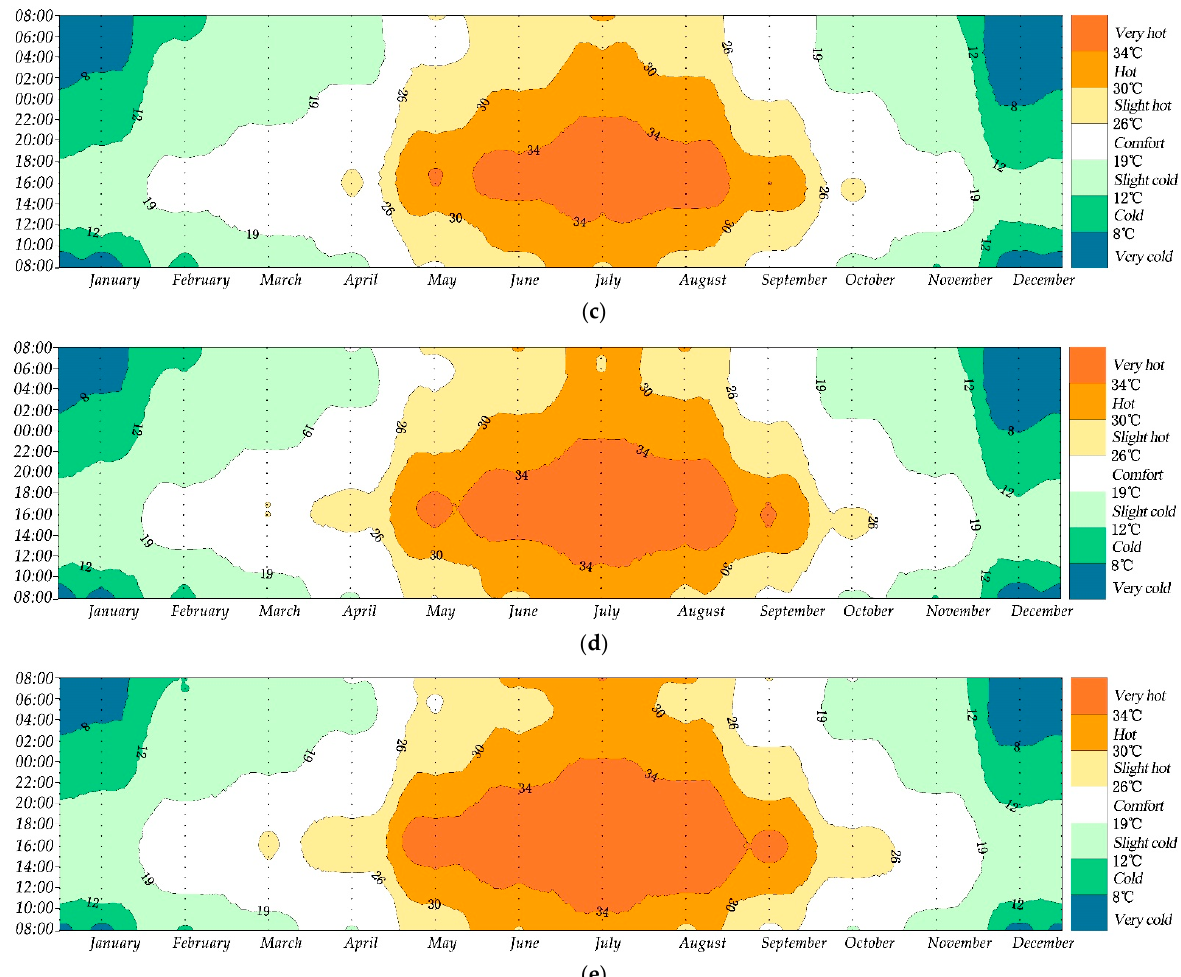
Figure 5. Distribution of annual indoor air temperature for 5 SVF scenarios. ( a ) Annual distribution of indoor air temperature for the five SVF (0.05). ( b ) Annual distribution of indoor air temperature for the five SVF (0.18). ( c ) Annual distribution of indoor air temperature for the five SVF (0.30). ( d ) Annual distribution of indoor air temperature for the five SVF (0.40). ( e ) Annual distribution of indoor air temperature for the five SVF (0.45).